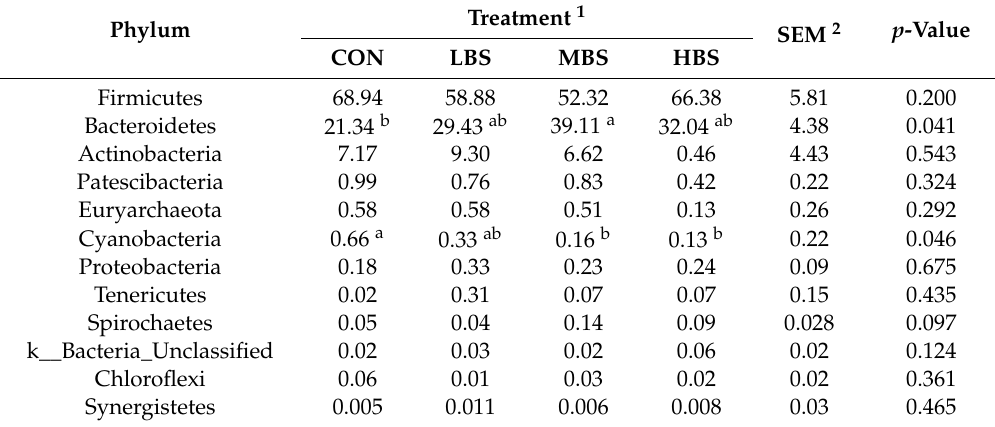
Table 5. E ff ects of β -sitosterol (BBS) supplementation on relative abundance in rumen fluid at phylum level. Treatment 1 Phylum SEM 2 p -Value CON LBS MBS